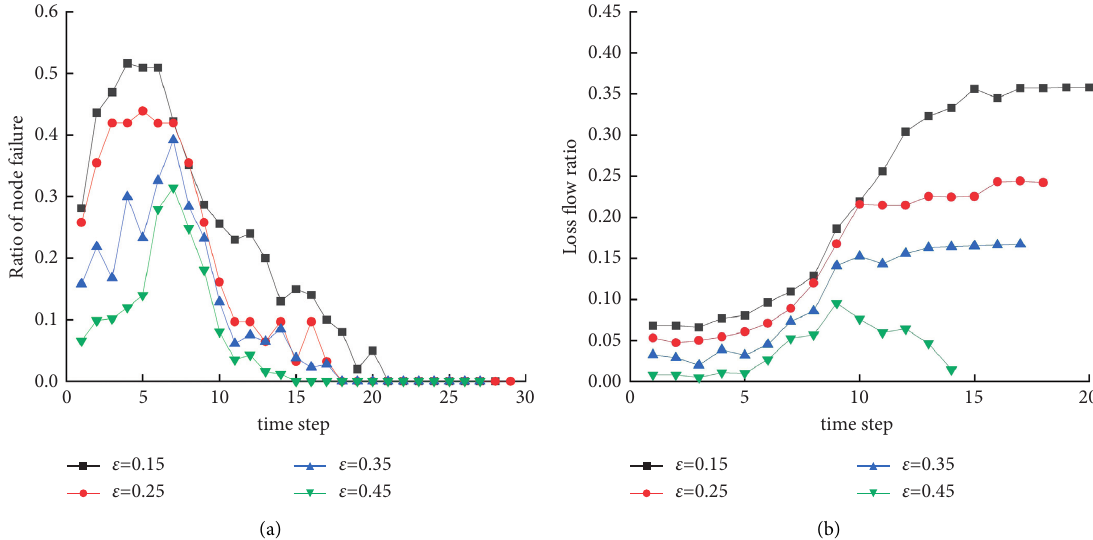
Figure 10: The vulnerability under the station with largest betweenness interruption. (a) Ratio of node failure. (b) Loss flow ratio.